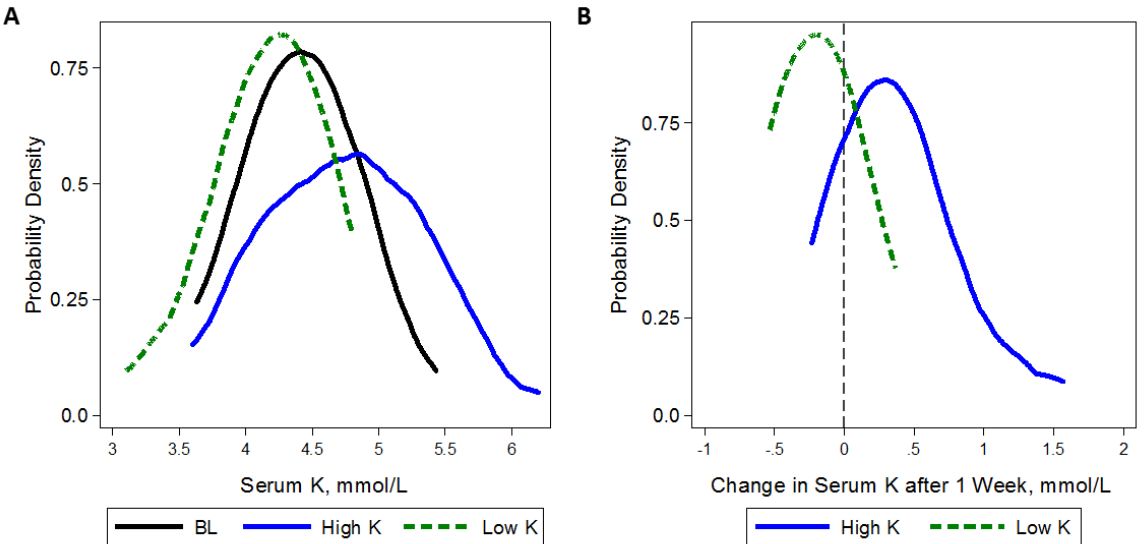
Figure 3. Kernel density plots of ( A ) serum potassium (K) levels (mmol/L) at baseline (BL) and after 1 week of higher (100 mmol/day, solid line) or lower (40 mmol/day, dash line) K intake; and ( B ) change in serum K levels after 1 week of higher (solid line) or lower (dash line) K intake. Baseline kernel density represents 3 measurements of serum K obtained after the Run-In visit, prior to starting the higher-K diet, and prior to starting the lower-K diet. In ( B ) gray vertical line represents a change of 0 mmol/L.